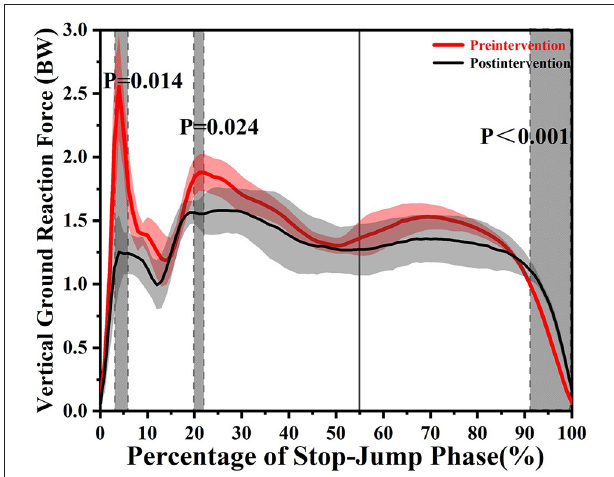
FIGURE 4 | The results of statistical parametric mapping (SPM) pre and post video tasks depicting vGRF. The solid line at 55% represents the time of maximum knee flexation. The gray region indicates a statistical differences ( p <